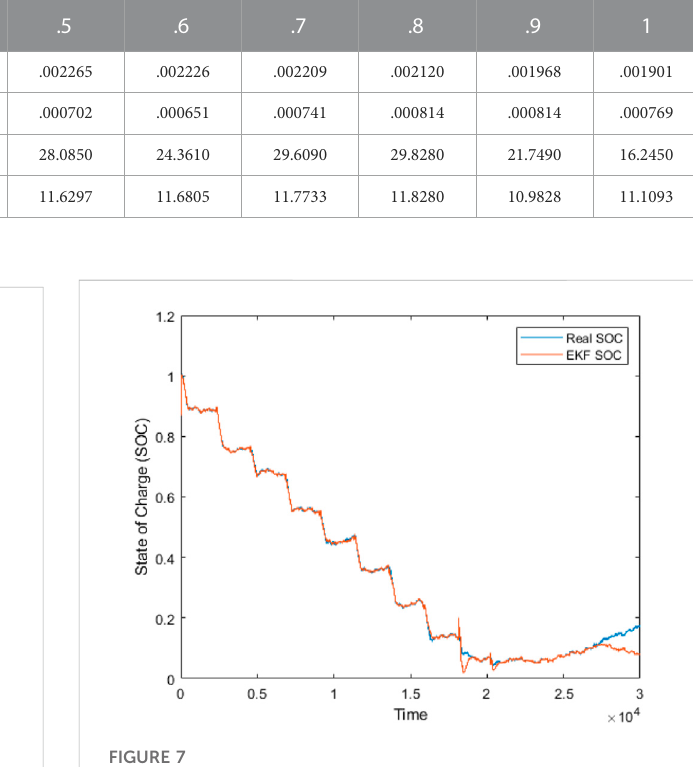
FIGURE 7 Extended Kalman fi lter response.